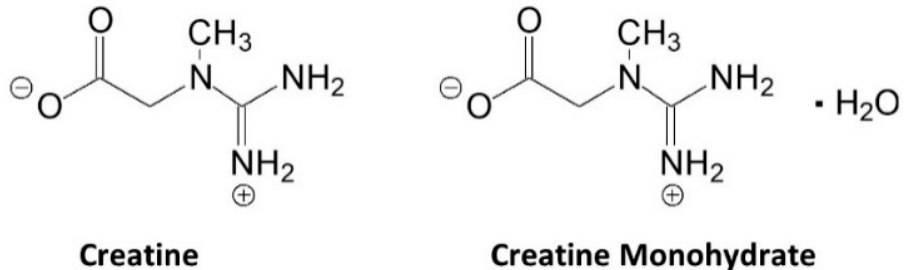
Figure 3. Chemical structure of creatine and creatine monohydrate.